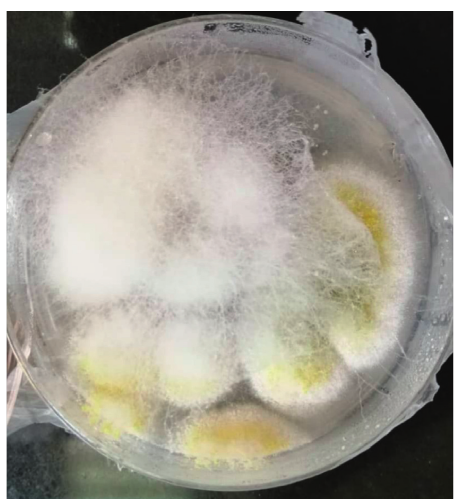
Figure 3: Colonies were identified as Aspergillus flavus and Rhizopus arrhizus .